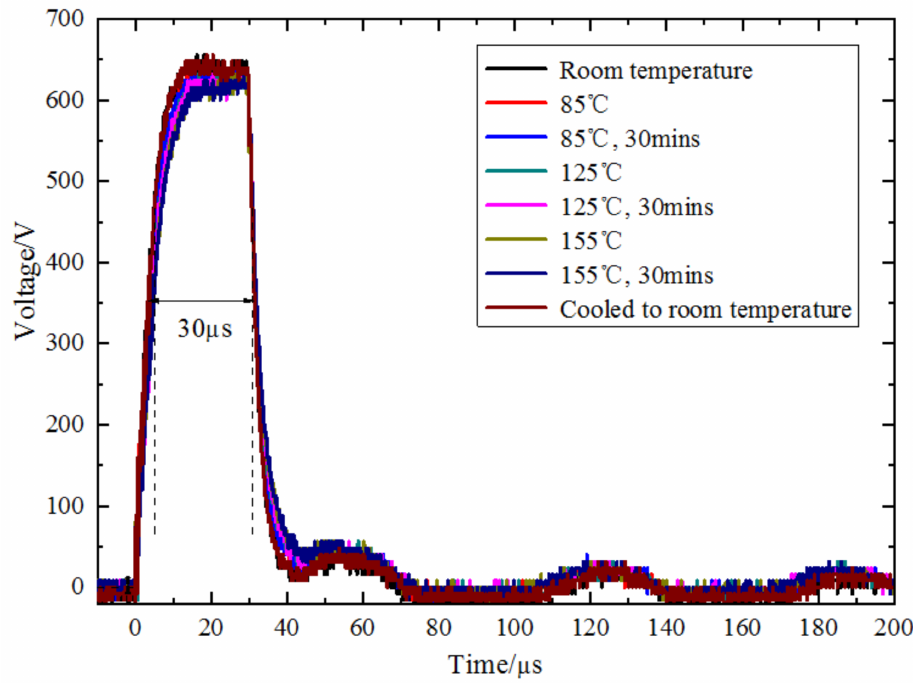
Figure 10. Excitation pulse signals of a piezoelectric vibrator at different temperatures.